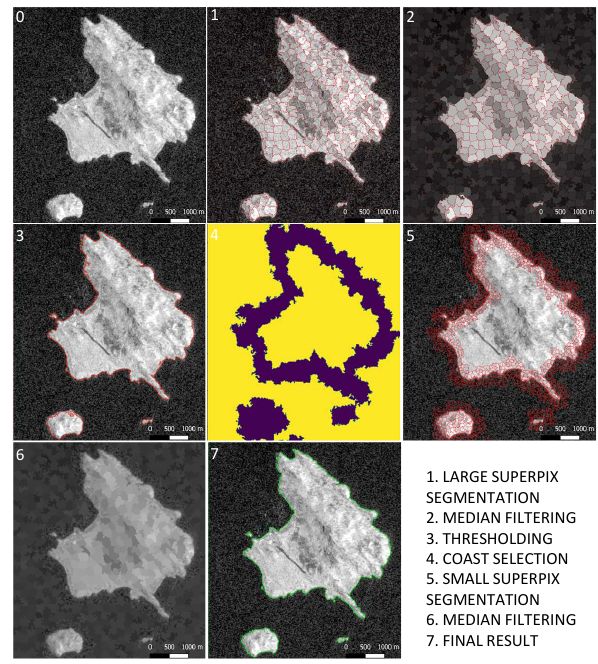
Figure 4. Pictorial representation of the algorithm steps.